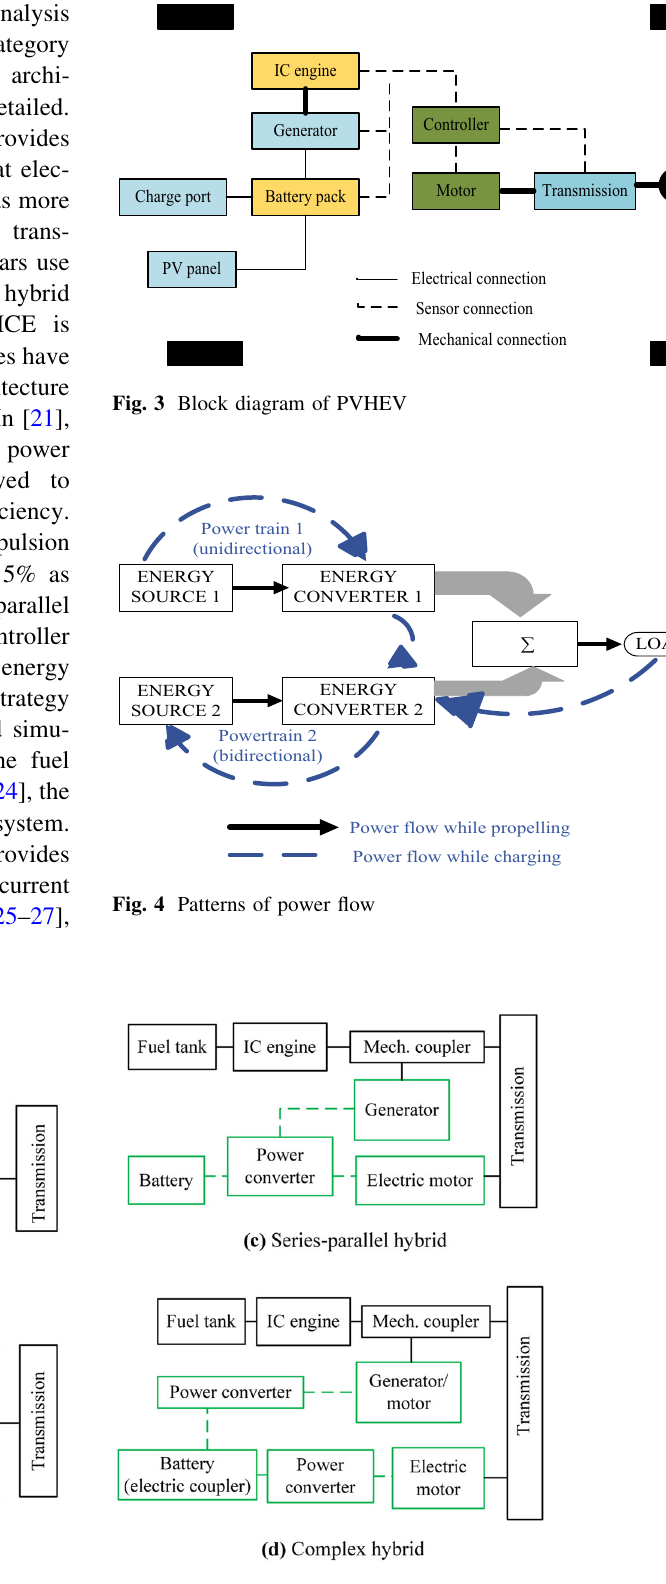
Fig. 2 Various architectures of an HEV